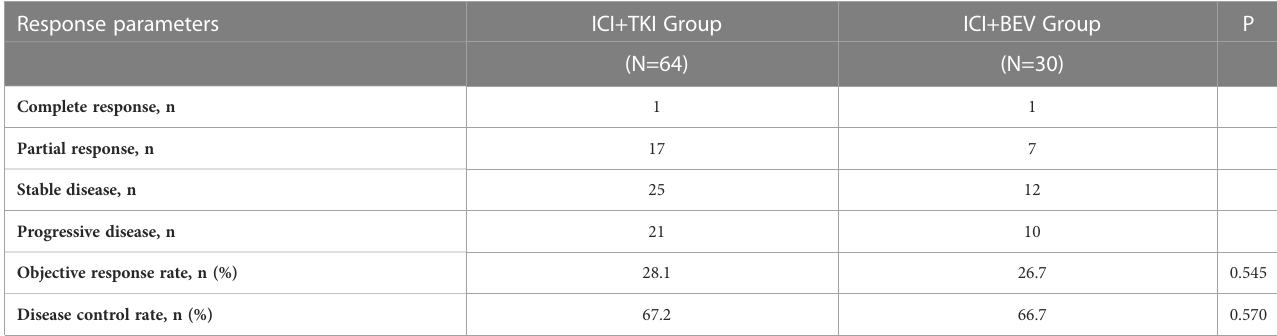
TABLE 2 Tumour responses according to RECIST version